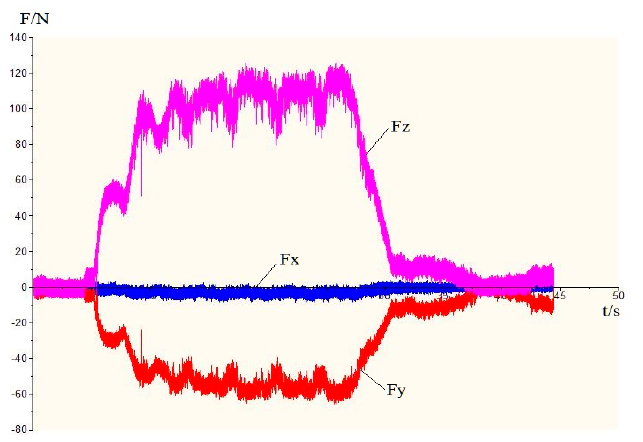
Figure 32. Curve of cutting force with time ( v c = 80 mm/min, f = 0.05mm/r, a p = 2 mm).